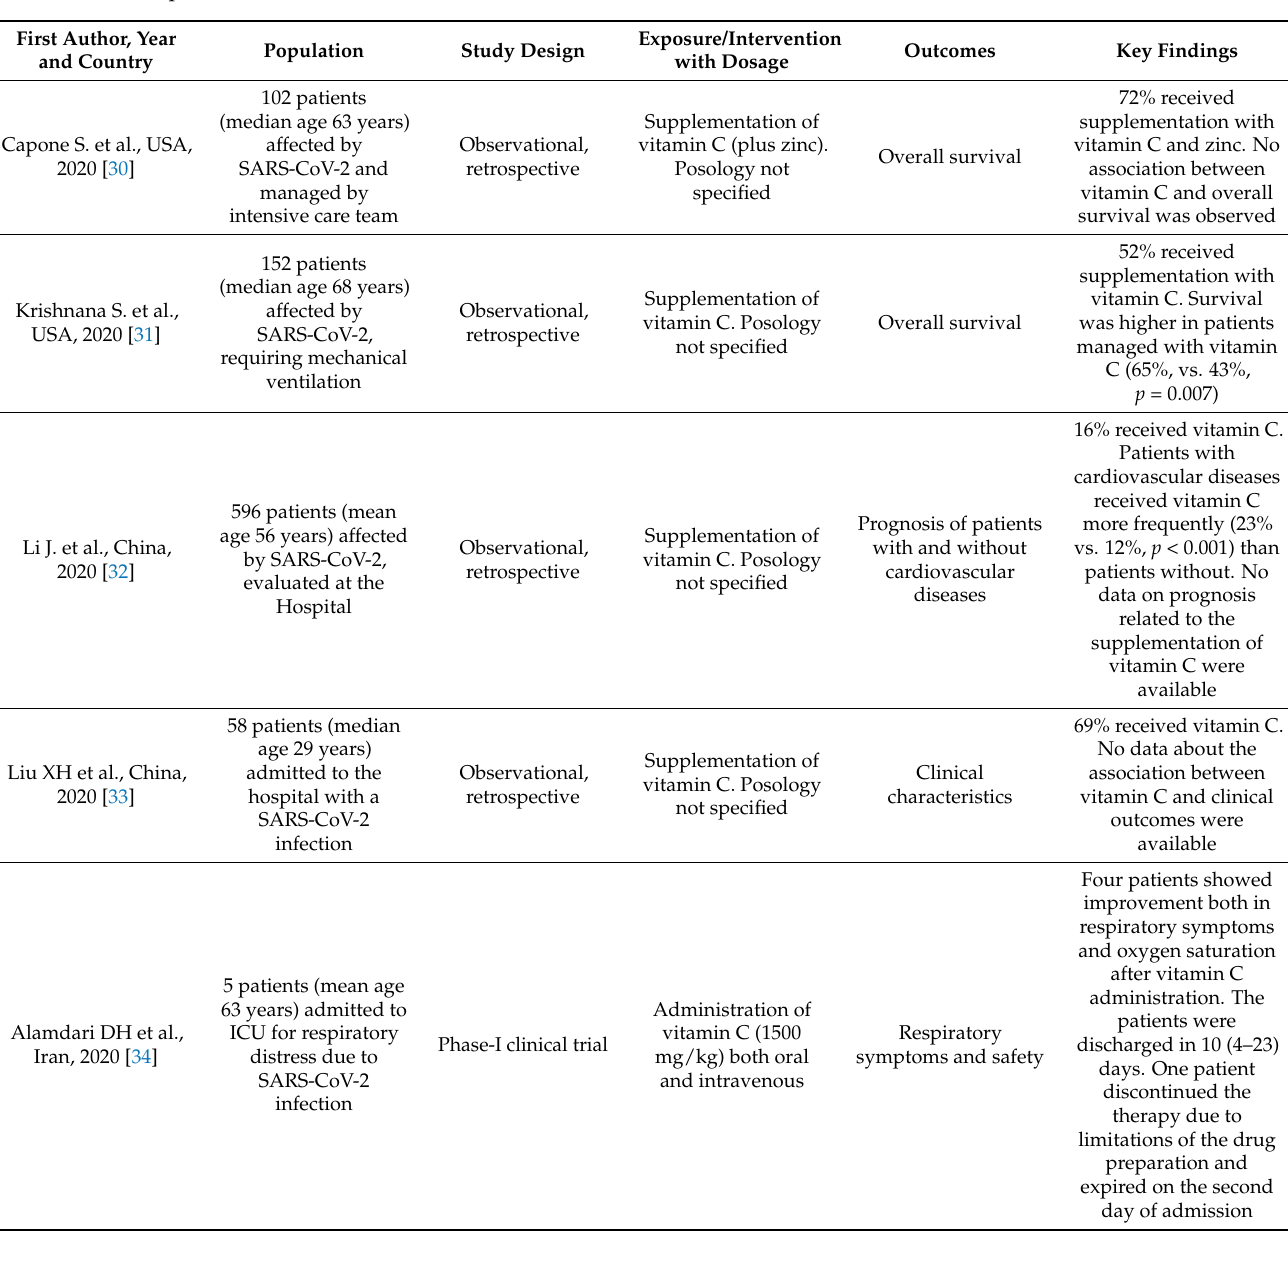
Table 1. Characteristics and findings of the concluded observational and interventional studies investigating the effect of vitamin C in patients with a SARS-CoV-2